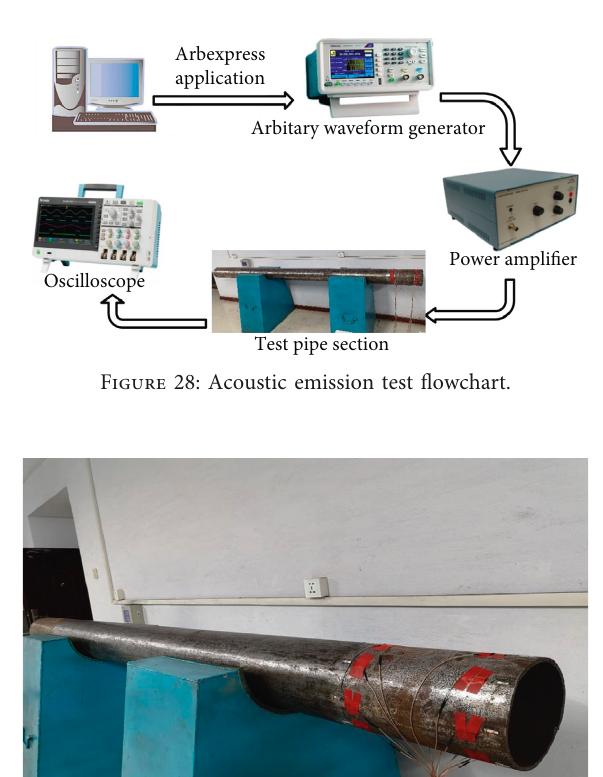
Figure 27: Double-defect guided wave imaging of the pipe section structure: (a) partial display, (b) distal detail, and (c) proximal detail.